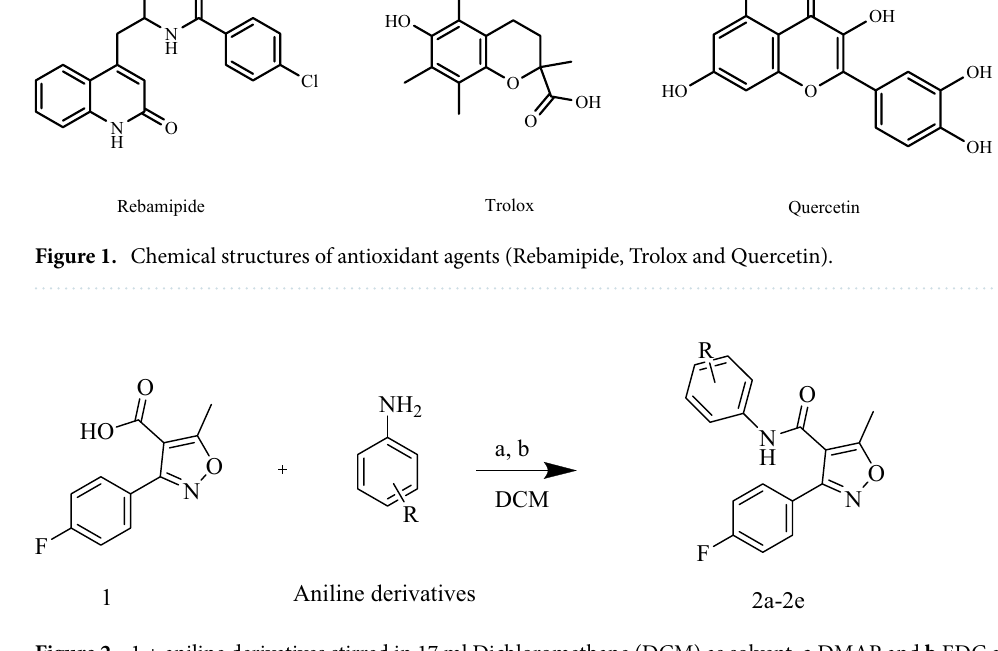
Figure 2. 1 + aniline derivatives stirred in 17 ml Dichloromethane (DCM) as solvent, a DMAP and b EDC all under inert gas and stirred for 72